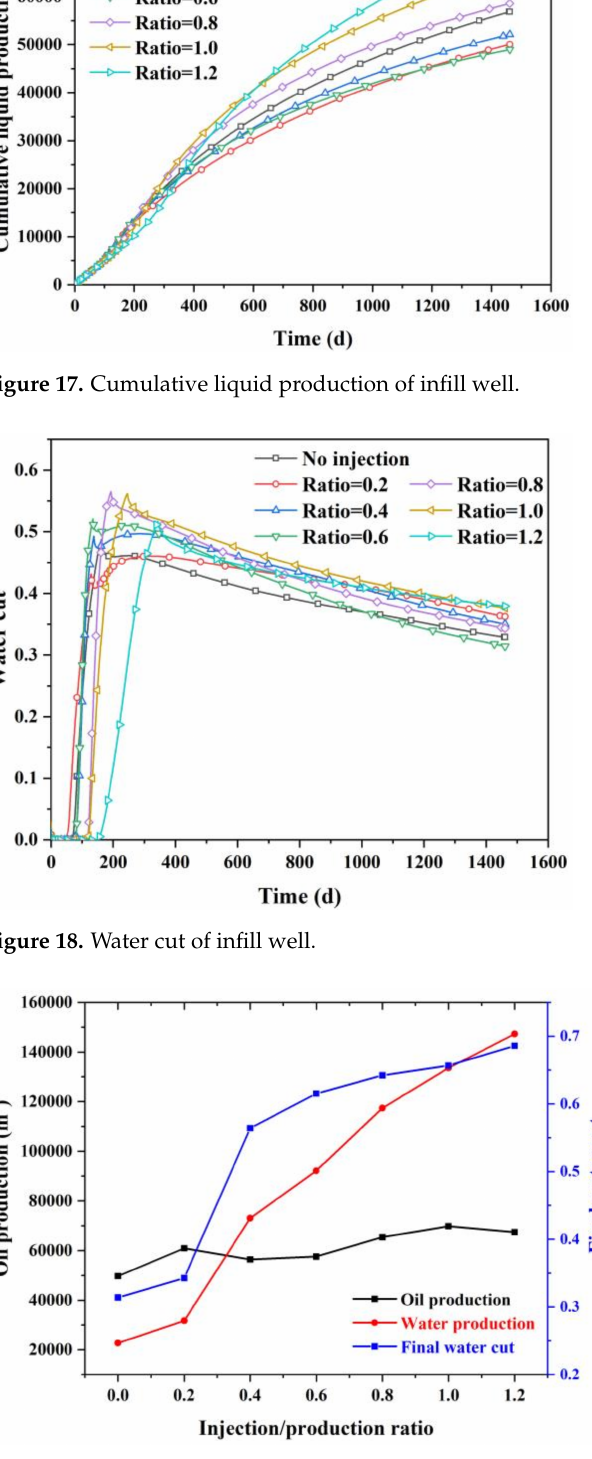
Figure 19. Liquid production and water cut of the well